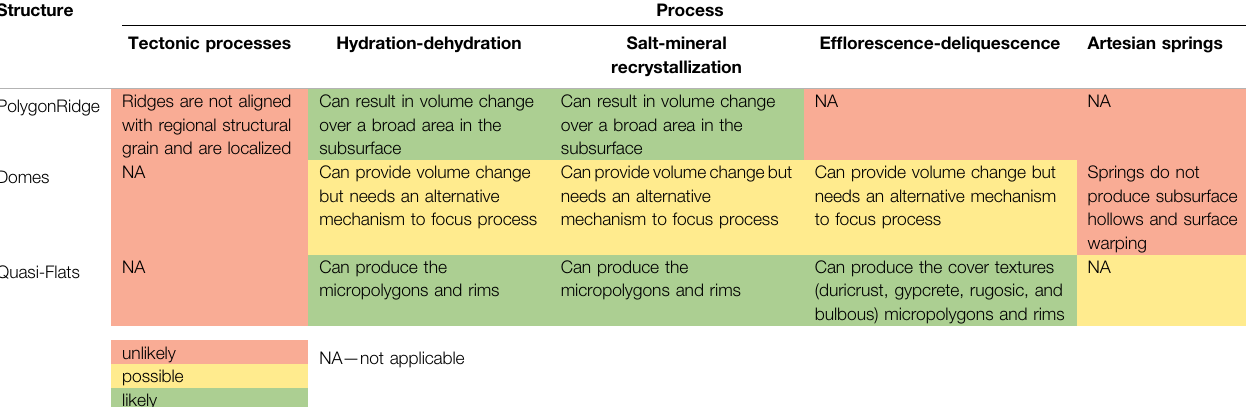
TABLE 3 | Possible mechanisms for formation of the macroscale